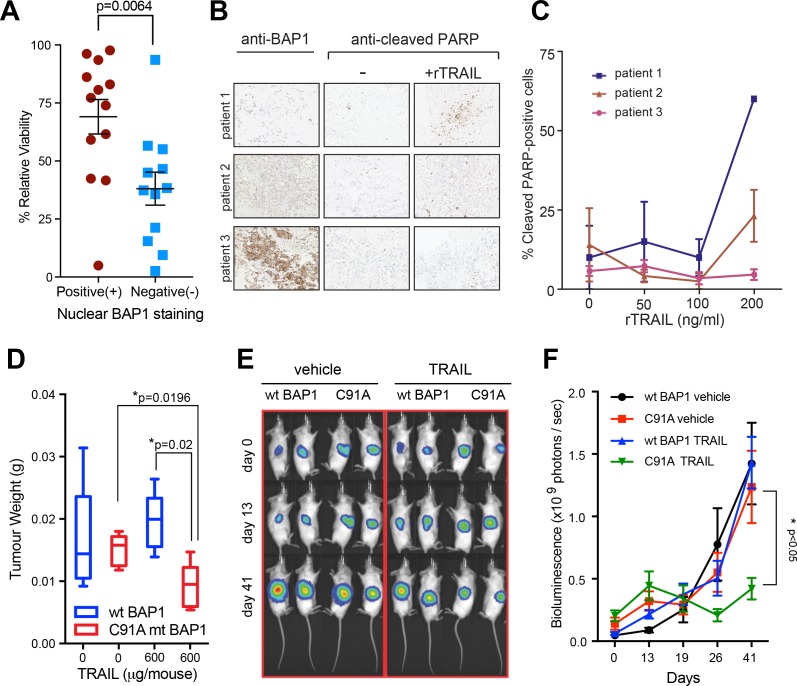
Loss of functional BAP1 leads to TRAIL sensitivity in early passage mesothelioma cell lines, human tumour explants and mouse xenograft models.(A) Mean cell viability effect between human early passage MM cell lines (positive nuclear BAP1 staining; n = 13 and negative nuclear BAP1 staining; n = 12) as assessed by immunohistochemistry following 3 days of treatment with rTRAIL (50 ng/ml) (t-test, p=0.0067). (B) Immunohistochemical images of tumour explants derived from three MM patients treated with either vehicle or rTRAIL for 24 hr. Explants were stained with anti-BAP1 and anti-cleaved PARP (marker for apoptosis) antibodies. (C) The percentage of cleaved PARP-positive cells in tumour explants derived from three patients and treated with either vehicle or 0, 50, 100 and 200 ng/ml of rTRAIL for 24 hr was scored based on the percentage of cells with nuclear cleaved PARP-positive staining. (D) Weights of tumour xenografts derived from BAP1-wild-type (wt BAP1) versus catalytically inactive BAP1-mutant (C91A mt BAP1) transduced MM cells following treatment with either vehicle or TRAIL (600 μg per mouse) at the time of sacrifice (day 42) (t-test). (E) Serial bioluminescence imaging of BAP1-wild-type (wt BAP1) and catalytically inactive BAP1-mutant (C91A) MM xenografts in mice treated with either vehicle or TRAIL. Mice were imaged on day 0 (after tumour inoculation), day 13 (before TRAIL administration) and day 41 (time of sacrifice). The intensity of luminescence is denoted by colour: red - high luciferase signal (high tumour burden) and blue - low luciferase signal (low tumour burden). (F) A time-course of bioluminescence scores in BAP1-wild-type (wt BAP1) versus catalytically inactive BAP1-mutant (C91A) MM tumour xenografts. Bioluminescence was measured on days 0, 13, 19, 26 and 41, 15 min after injecting the mice with 0.2 ml luciferin intraperitoneally. The number of photons emitted per second indicates the tumour burden (two way ANOVA).